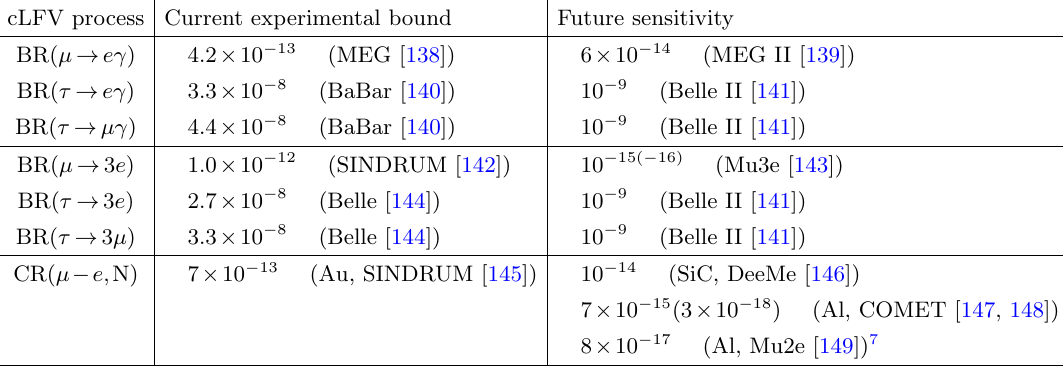
Table 3 . Current experimental bounds and future sensitivities of various cLFV processes considered in the